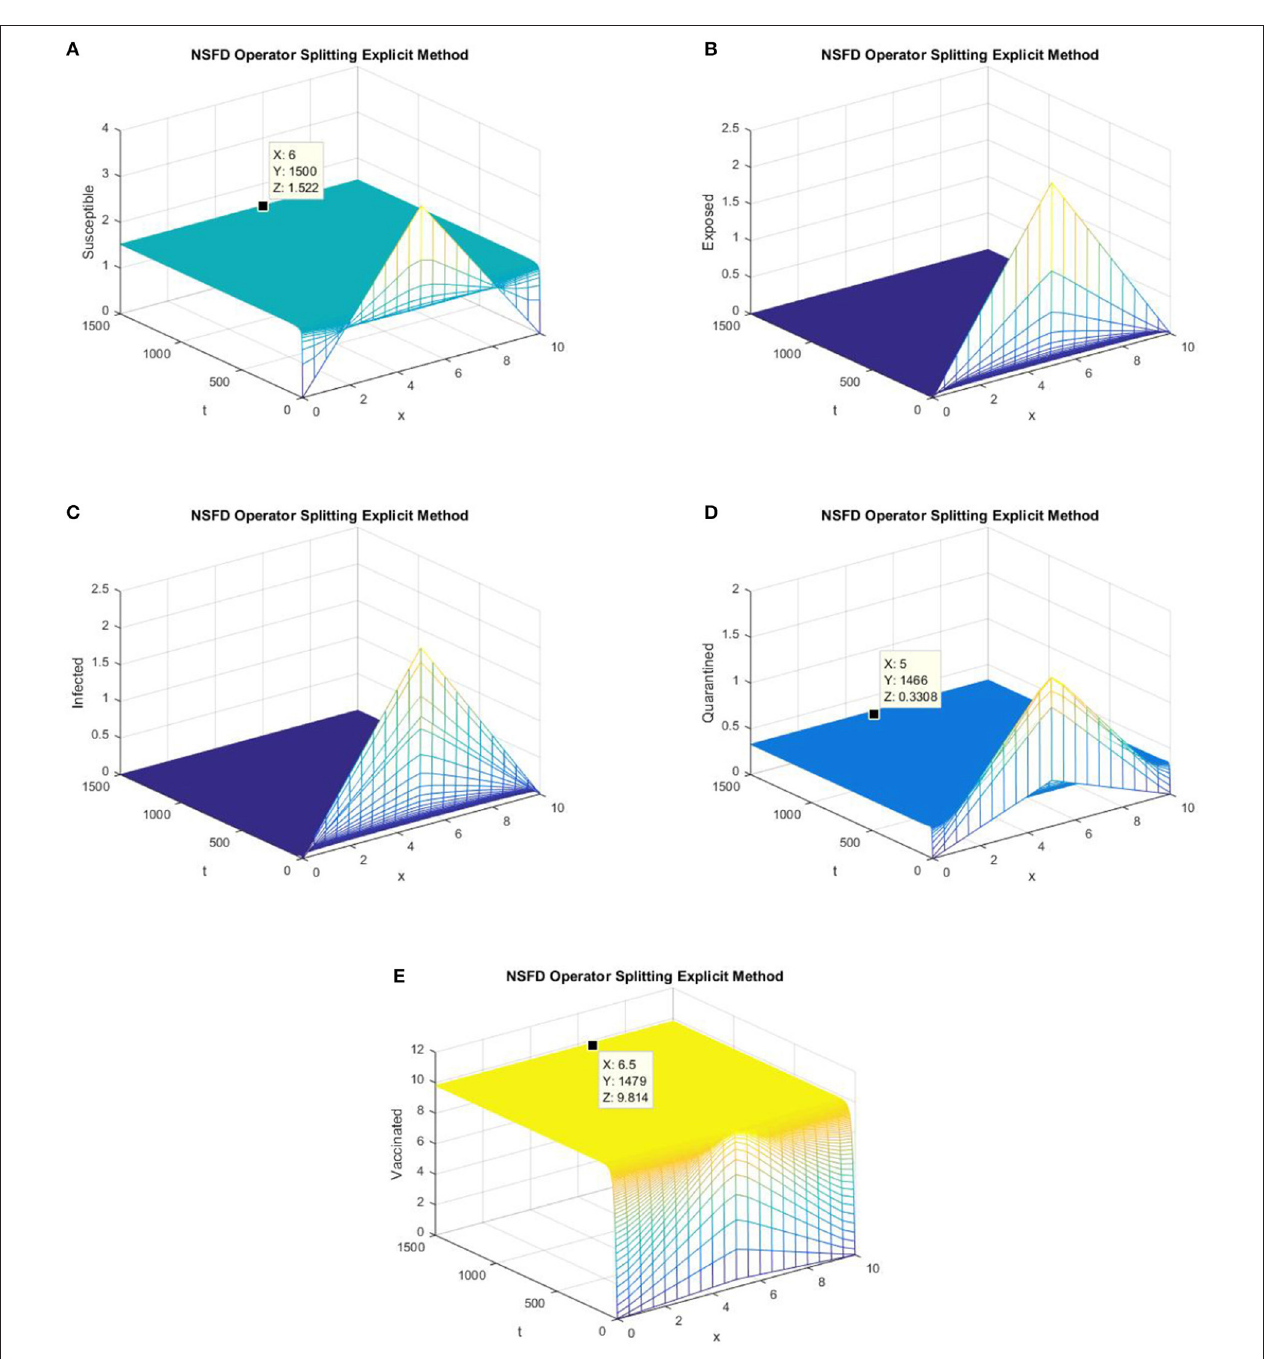
FIGURE 1 | The explicit operator splitting NSFD scheme is used to simulate the graphs (A–E) . (A) Mesh graph of S ; (B) Mesh graph of E ; (C) Mesh graph of I ; (D) Mesh graph of Q ; (E) Mesh graph of V .